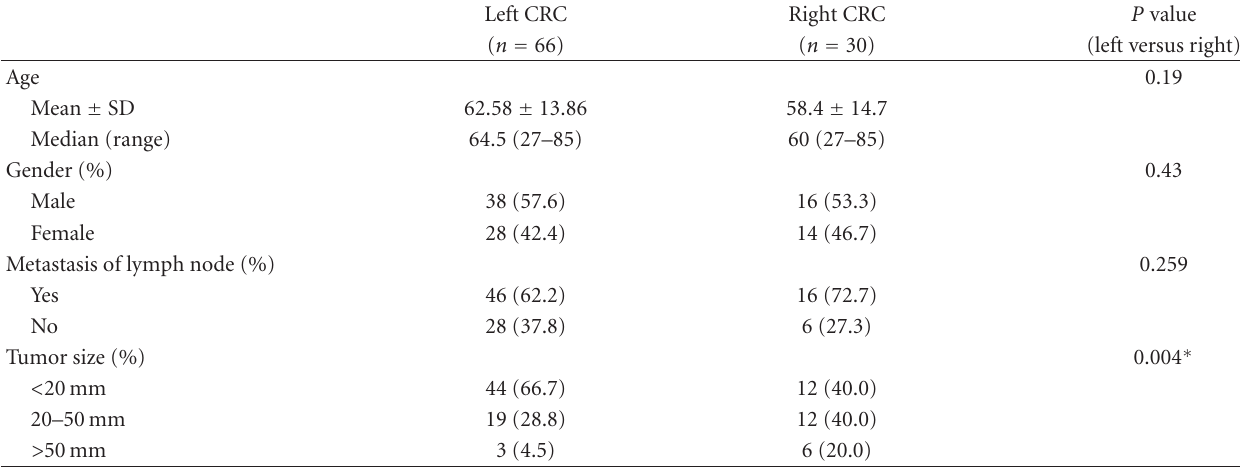
Table 2: Clinicopathological features of colorectal cancers patients according to site of tumor.